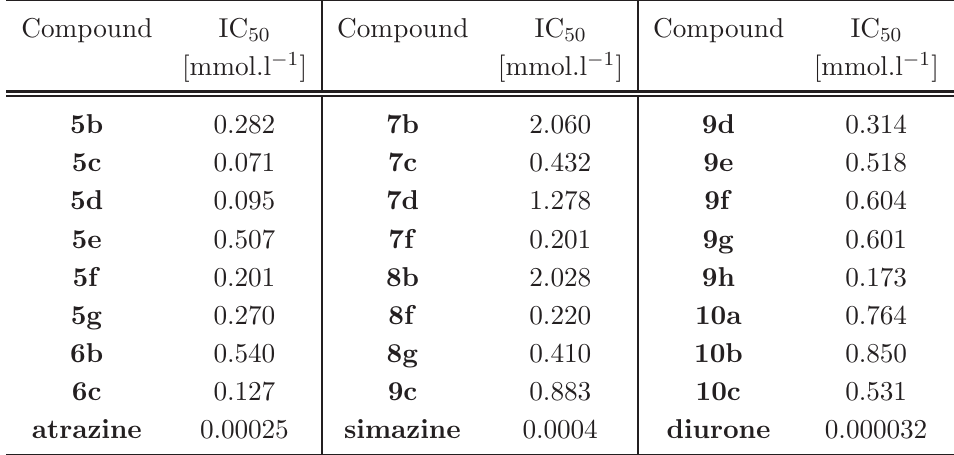
Table 2 Comparison of inhibitory effect of compounds 5-10 and three commonly used standards on photosynthetic electron transport in spinach